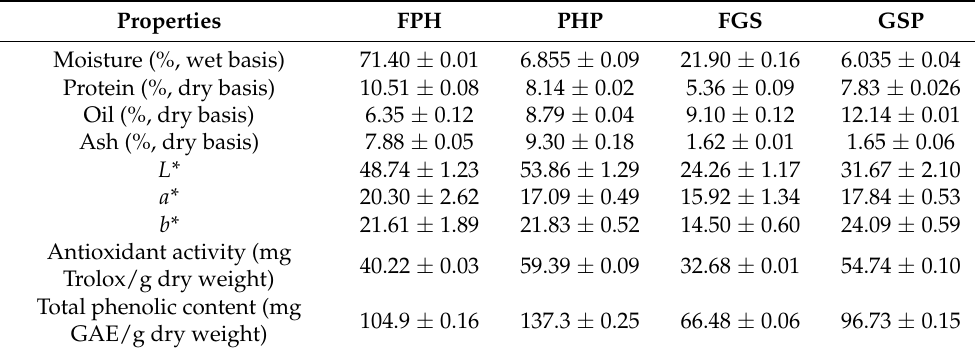
Table 1. Proximate compositions, color values, antioxidant activity, and total phenolic content of fresh and powdered pistachio hulls and grape